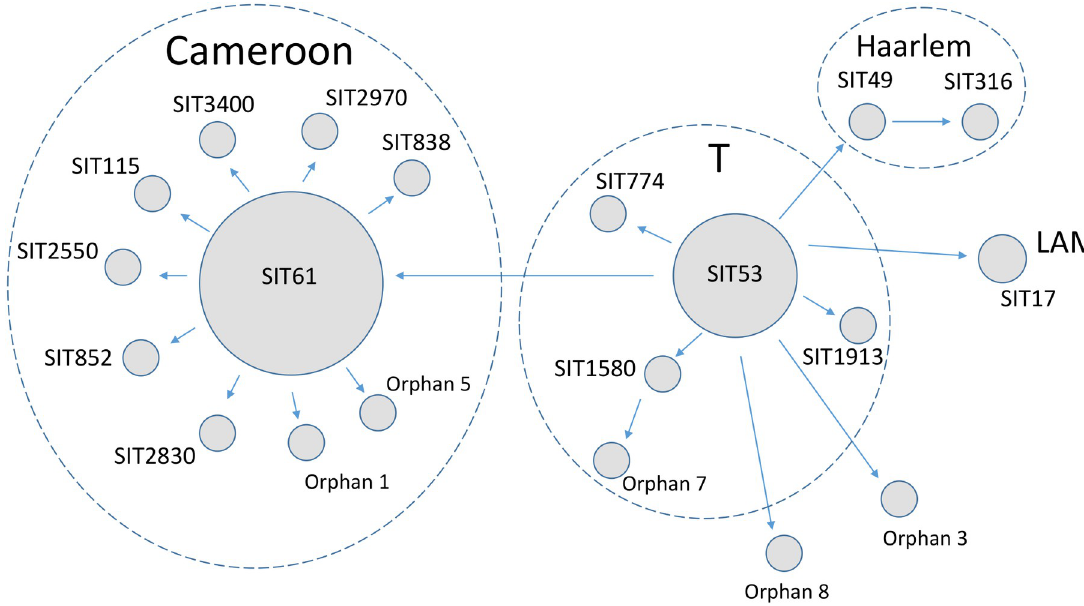
Fig 1. Spoligoforest of 67 M . tuberculosis isolates from the Plateau State, Nigeria, illustrating the potential evolutionary relationships of the spoligotypes identified in this study.